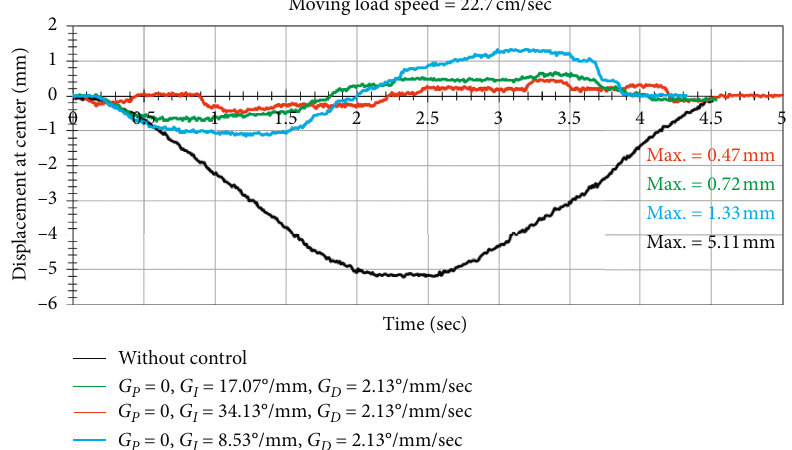
Figure 13: Comparison of the time histories of the displacement responses for the bridge under a load of a high-speed vehicle without and with NEM control and various gain